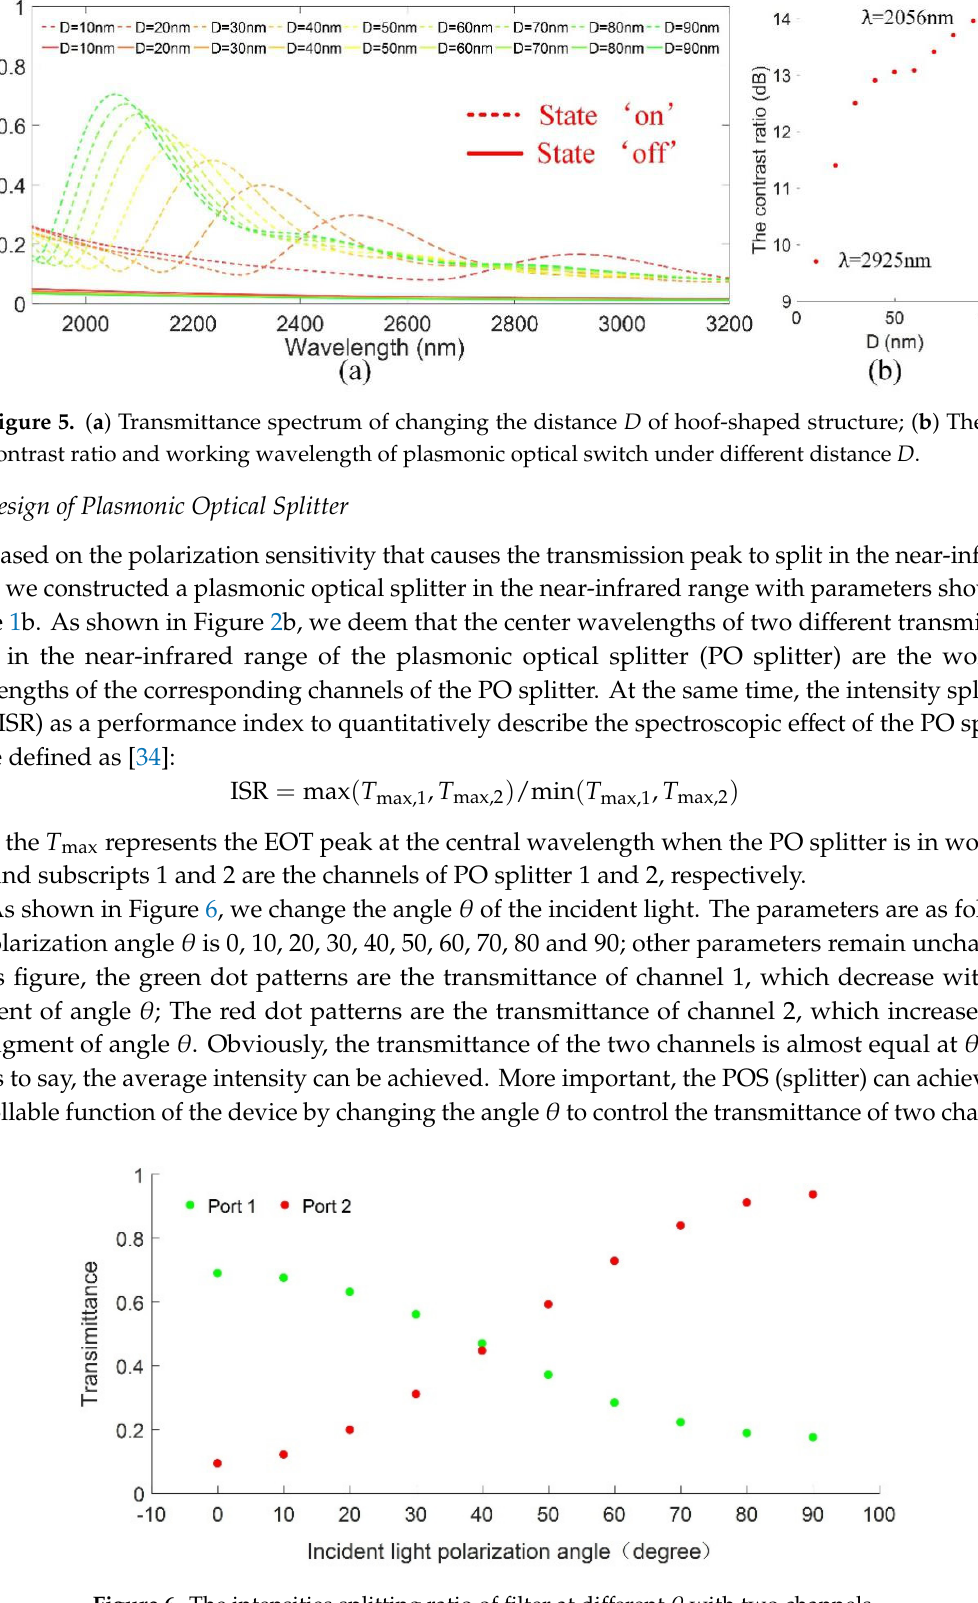
Figure 6. The intensities splitting ratio of filter at di ff erent θ with two channels.